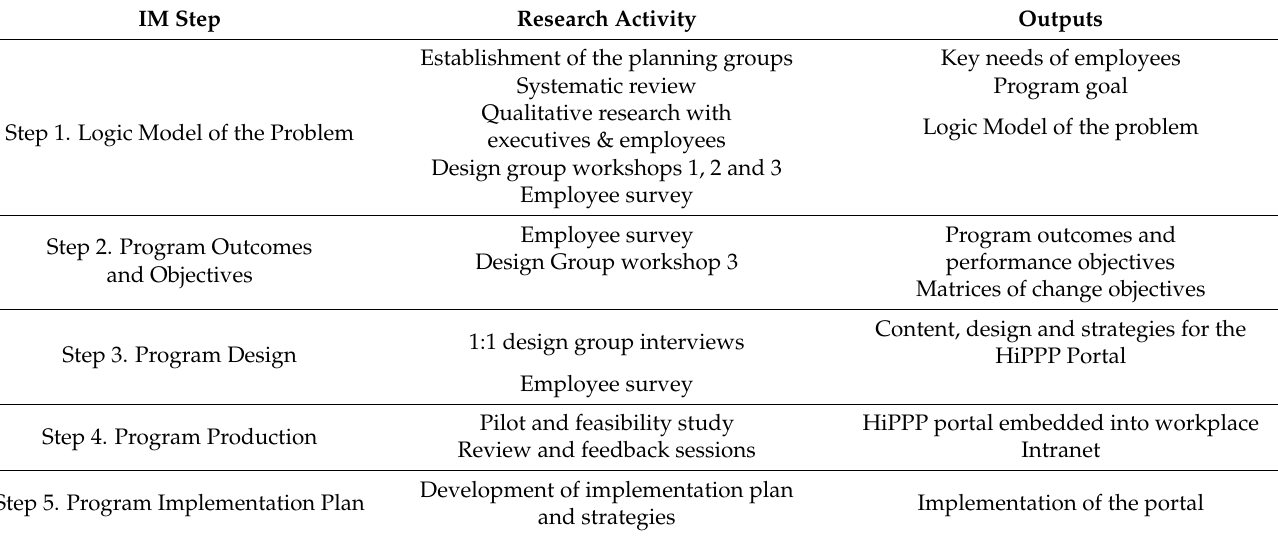
Table 1. IM steps, research activities and